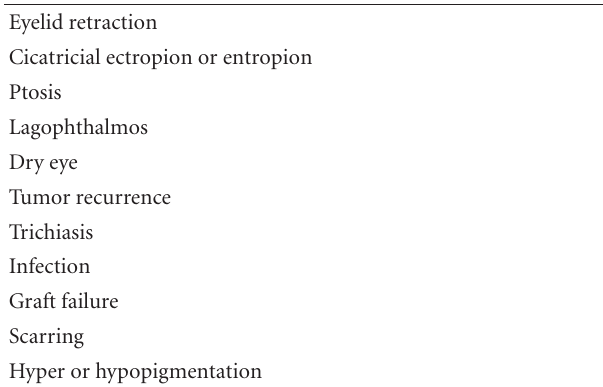
Table 1: Complications of eyelid